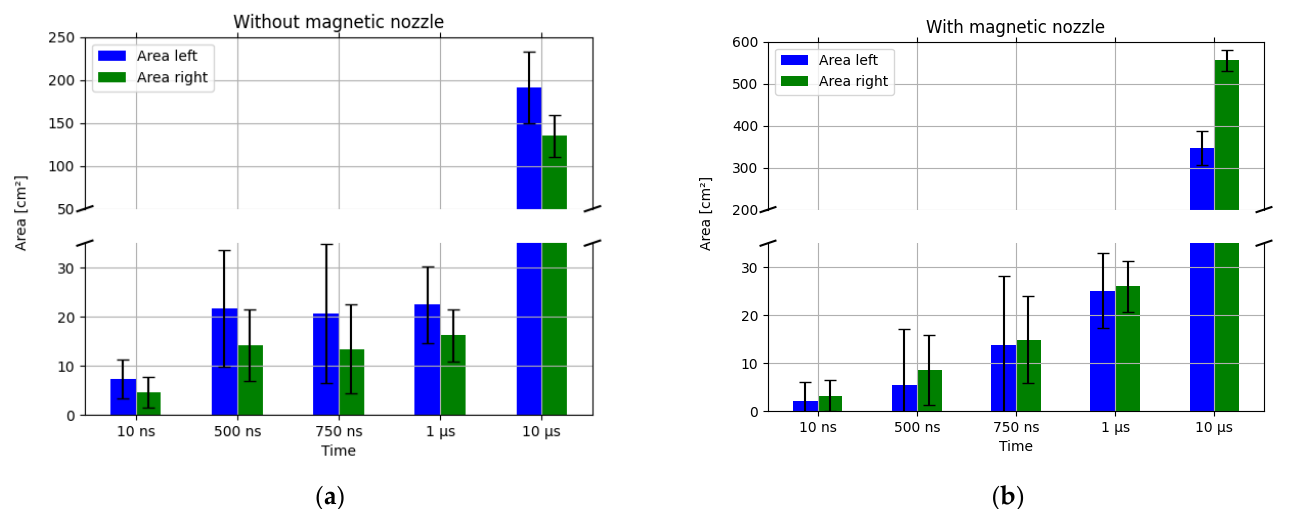
Figure 11. Calculated areas (blue: left direction of observation; green: right direction of observation) from the sliced contours of both perspectives: ( a ) thruster without magnetic nozzle; ( b ) thruster with magnetic nozzle.